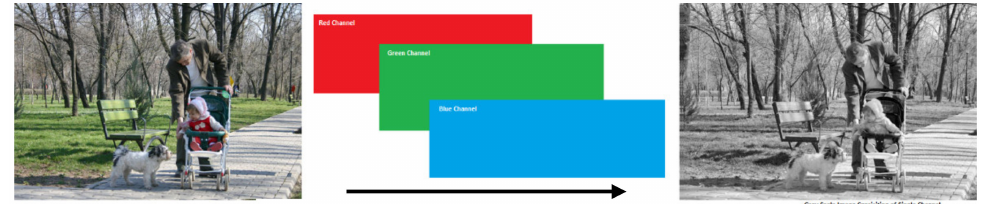
Figure 6. Channel Representation of RGB.